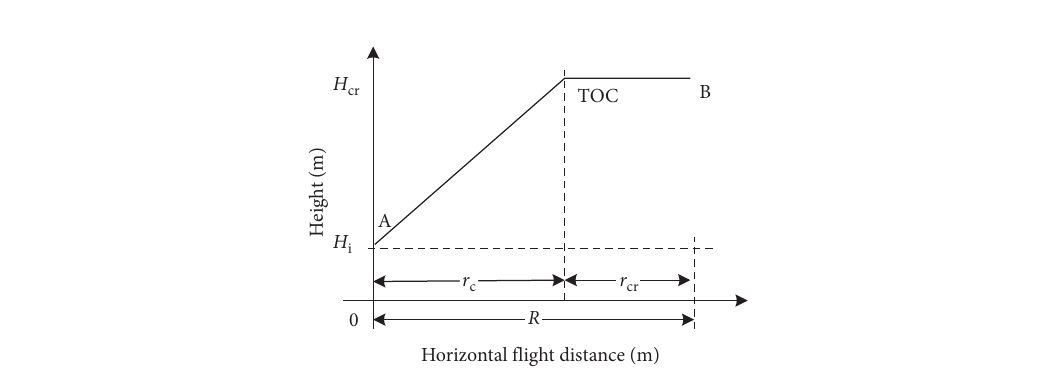
Figure 1: Problem research framework.